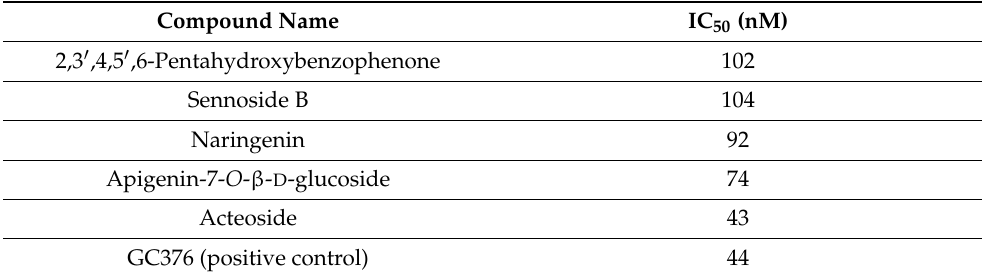
Figure 1. Screening of top hit compounds towards SARS-CoV-2 M PRO utilizing FRET assay. Table 2. IC 50 of most active compounds compared to GC376 (Standard 3CL Protease enzyme inhibitor) on SARS COV-2 viral main